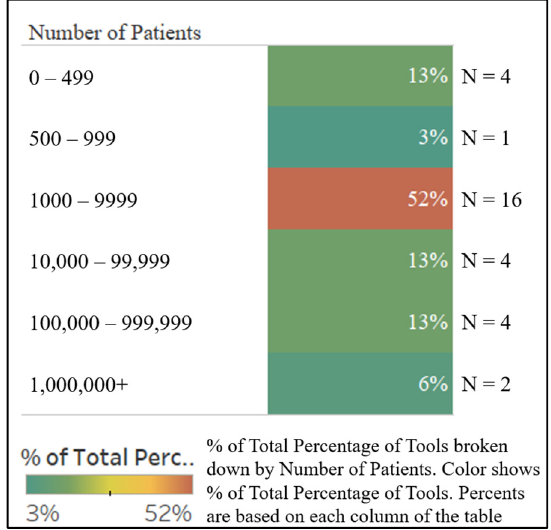
Figure 2. Study size used in tool creation.